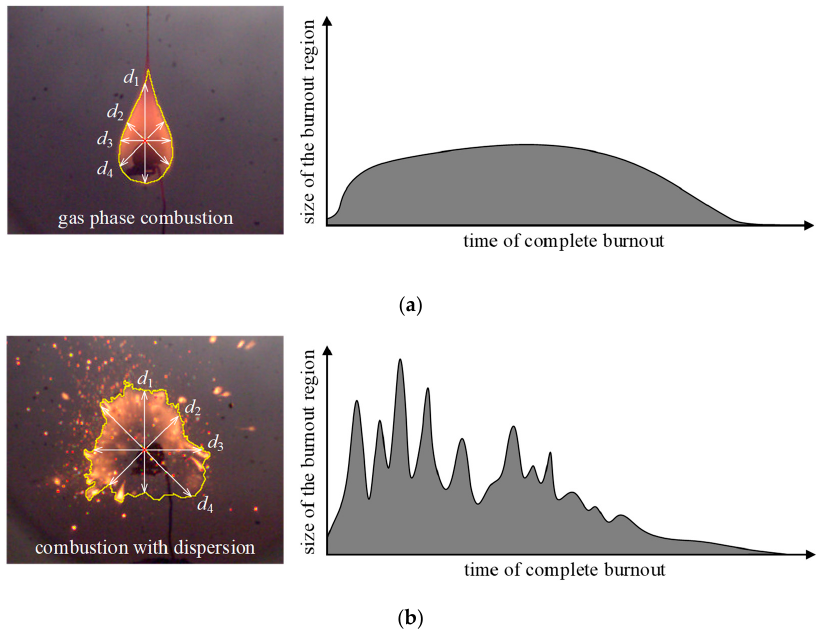
Figure 3. Visualization of the video frame processing for determining the size of the burnout region of fuel components without dispersion ( a ) and with dispersion ( b ).